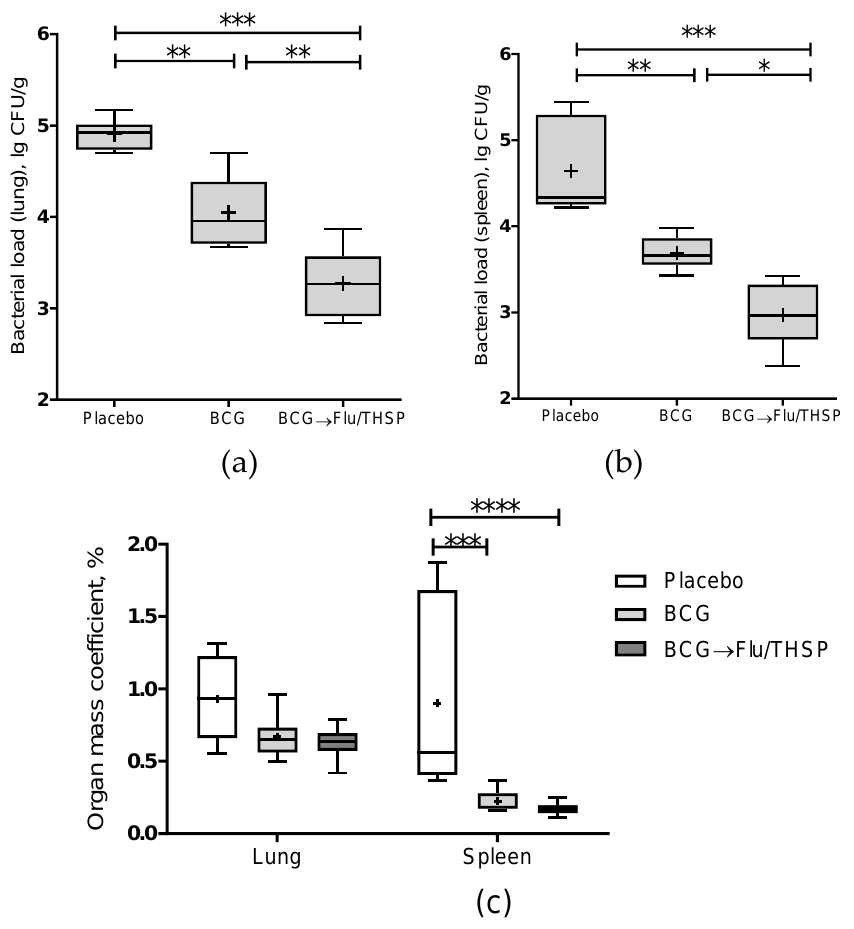
Figure 6. Protective efficacy of BCG-prime → Flu/THSP boosts immunization in a guinea pig model of TB infection. Vaccinated guinea pigs were challenged with virulent M.tb H37Rv strain and analyzed 8.5 weeks post TB infection. ( a ) Bacterial load in the lungs and ( b ) spleen was measured by the titration of tissue homogenates; ( c ) Organ mass coefficients were estimated as the percentage of organ weight relative to body weight. Statistical significance was measured by two-way ANOVA (familywise p < 0.0001) with the Bonferroni post-hoc-test for a pairwise comparison (* p < 0.05, ** p < 0.01, *** p < 0.001, and **** p < 0.0001).